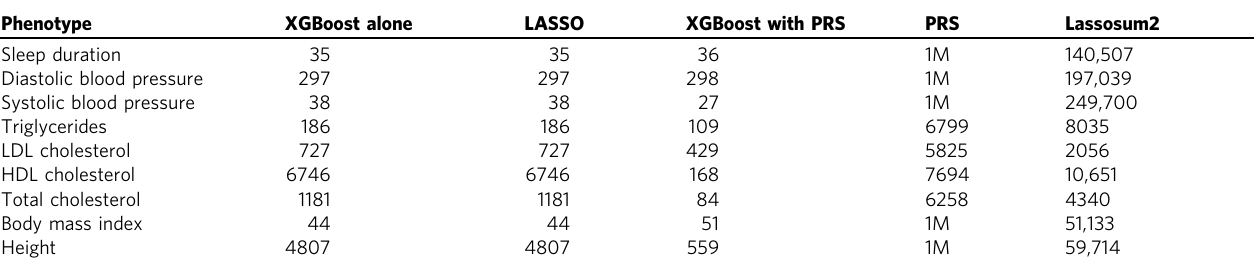
Table 2 Number of SNPs selected through cross-validation for the PRS and XGBoost Model.